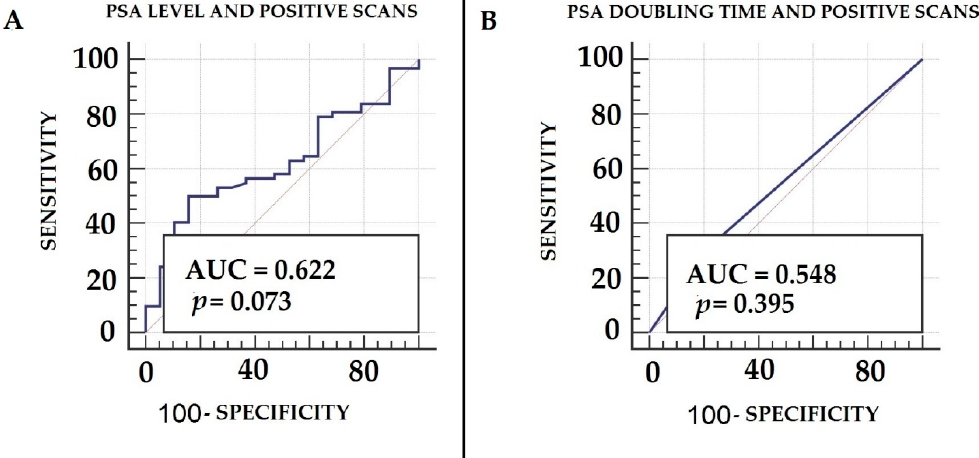
Figure 3. ROC curve analysis shows the accuracy of the PSA level ( A ) and PSA doubling time ( B ), measured prior to 18 F-FACBC PET/CT scan, for predicting positive results.